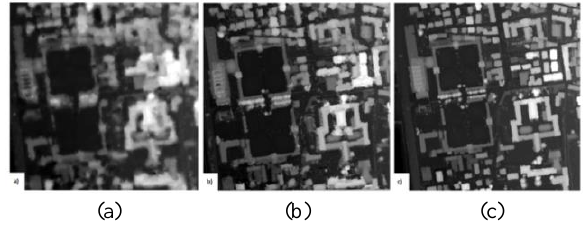
Figure 1. Example of DSM data extracted from Geoeye stereo- pair (a), airborne images (b) and LIDAR data (c).